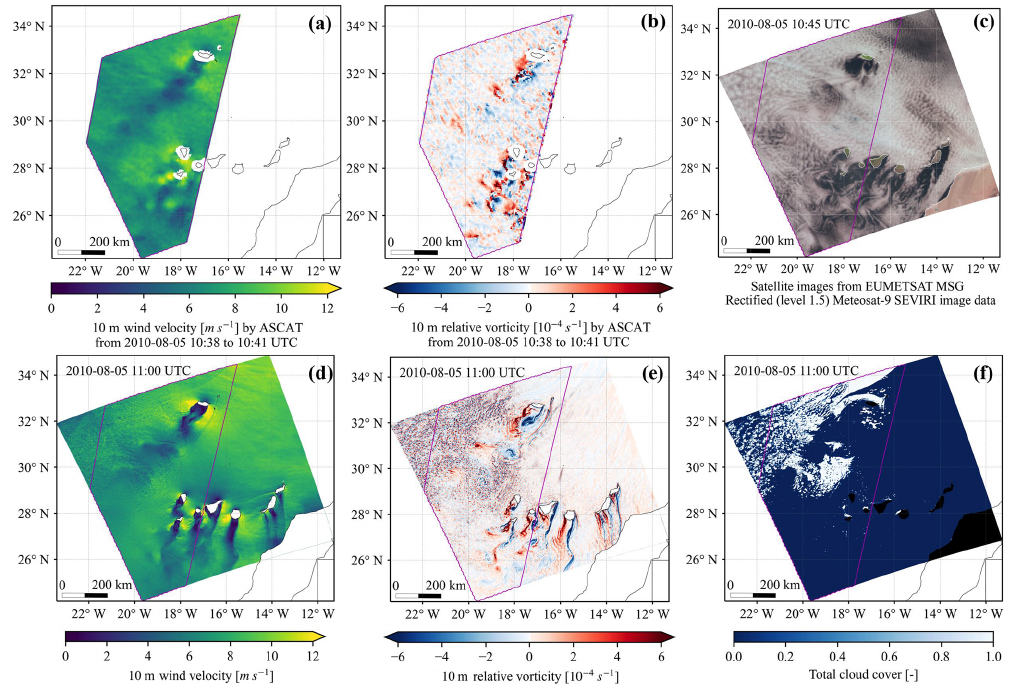
Figure 13. Comparison of (a–c) satellite data versus (d–f) simulation data: (a) 10m winds and (b) the derived relative vorticity at a horizontal resolution of 6.25km measured by ASCAT on board Metop-A from EUMETSAT. The magenta polygons indicate the area with available ASCAT data over the analysis region. (c) Satellite image constructed with data observed by MSG Meteosat-9 from EUMETSAT. The NIR1.6, VIS0.8 and VIS0.6 channel data were used to represent red, green and blue. The second row shows (d) 10m winds, (e) the derived relative vorticity and (f) total cloud cover in CRS1 at a time point (5 August 2010 at 11:00UTC) close to that of observations. The geographic map is from Natural Earth.